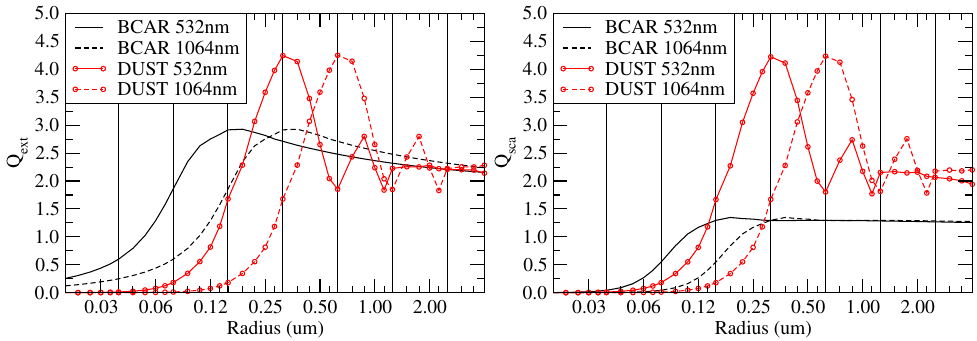
Fig. 2. Black carbon (BCAR) and mineral dust (DUST) extinction ( Q ext ) and scattering ( Q sca ) efficiencies as a function of size (radius) for